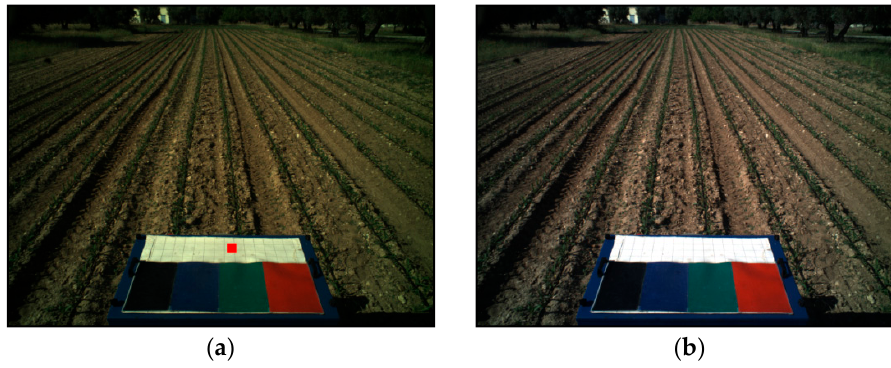
Figure 4. White balance: ( a ) original image; ( b ) corrected image.